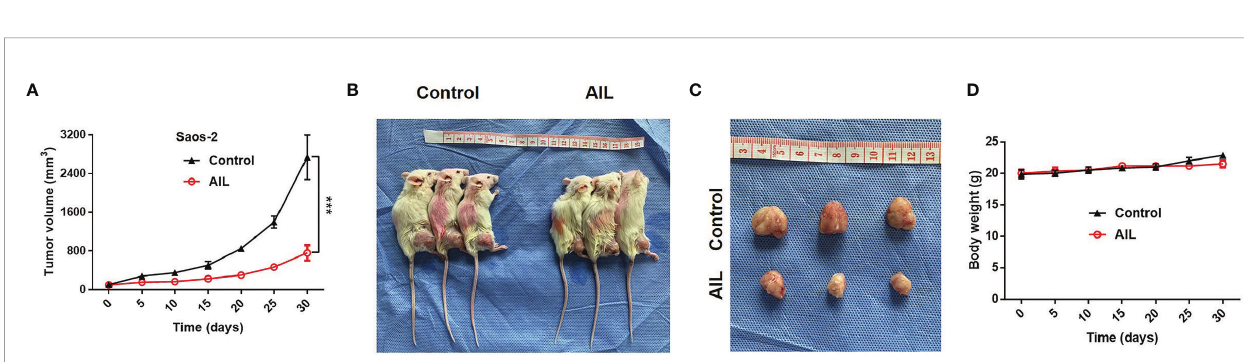
FIGURE 1 | AIL inhibited proliferation, migration and invasion of OS cells. (A) After exposure to various concentrations (0.039-10 µM) of AIL for 24 h and 48h, the viability of Saos-2 and U-2OS cells was assessed with a CCK-8 assay. The cell viability decreased dose- and time-dependently. (B) After incubation with various concentrations of AIL, the wound healing assay indicated that AIL impaired wound healing dose-dependently. (C) Transwell assays showed that the invasion rates of OS cells decreased dose-dependently in the AIL groups. (D) Comparisons of the migration rates and relative invasion rates between the AIL and control groups are shown (*** P < 0.001 compared with the control).